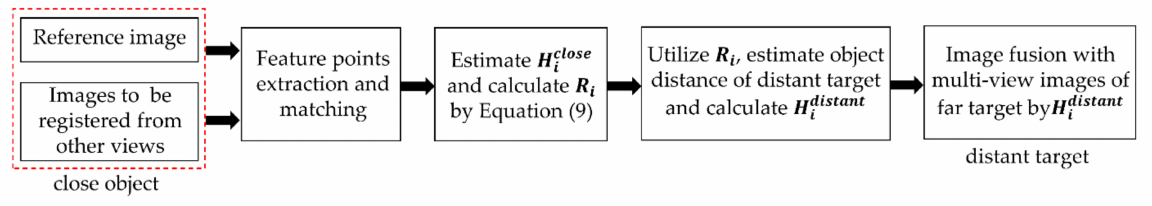
Figure 2. Overall process of